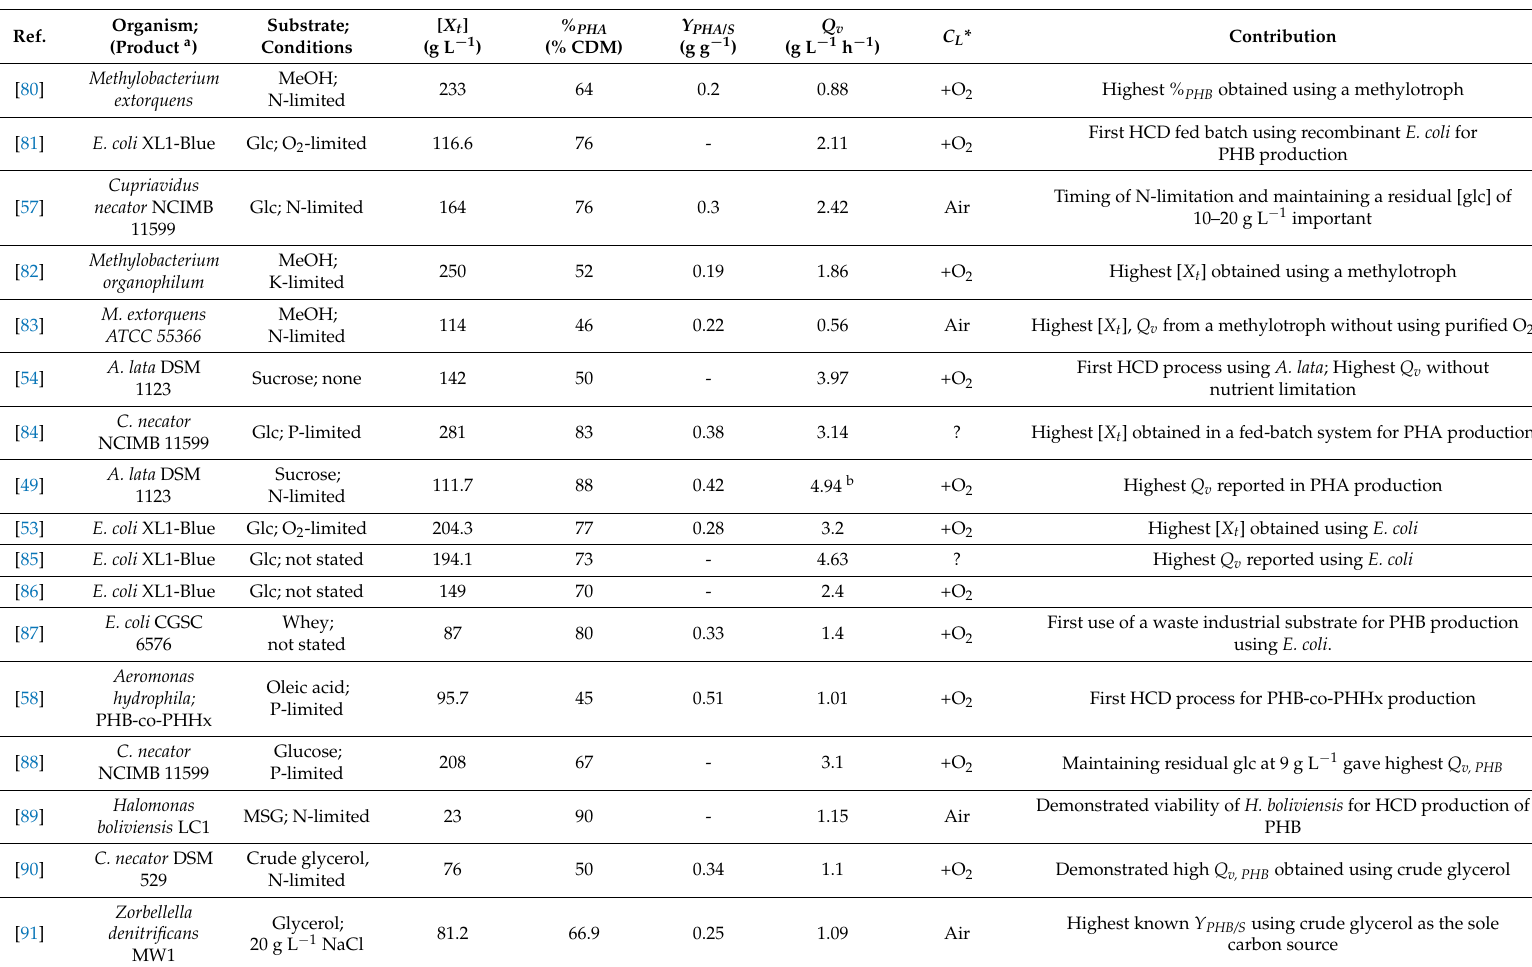
Table 2. Chronological summary of process developments for high-productivity fed-batch bioreactor systems in short-chain length (scl)-PHA research.